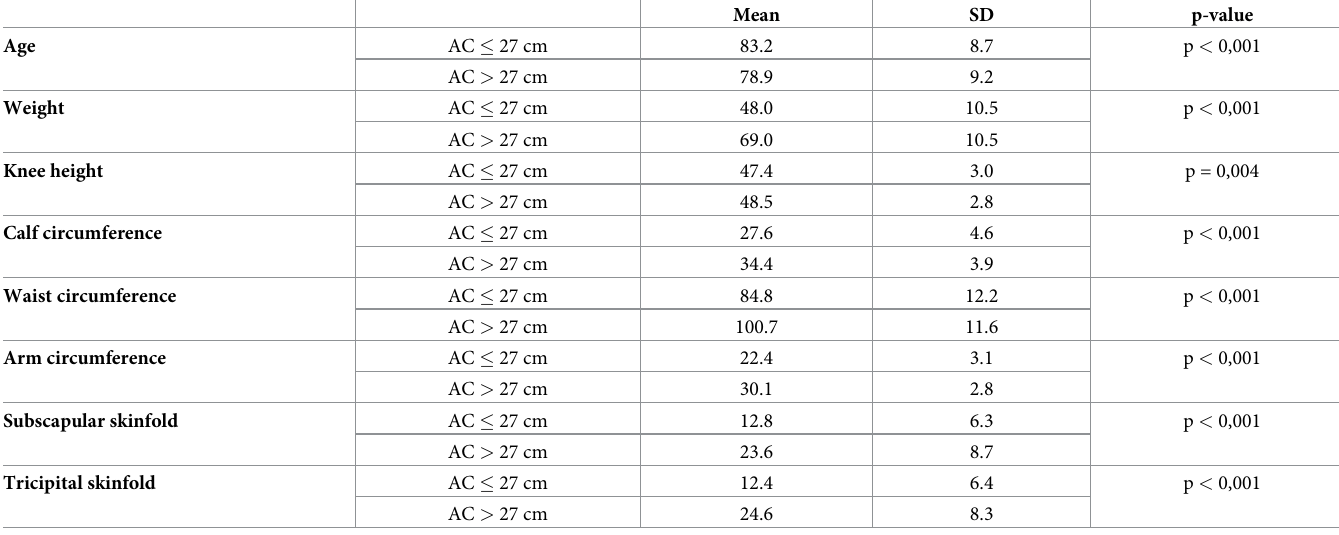
Table 2. Mean difference between anthropometric variables and the group of older adults with AC � 27 cm and AC > 27 cm.